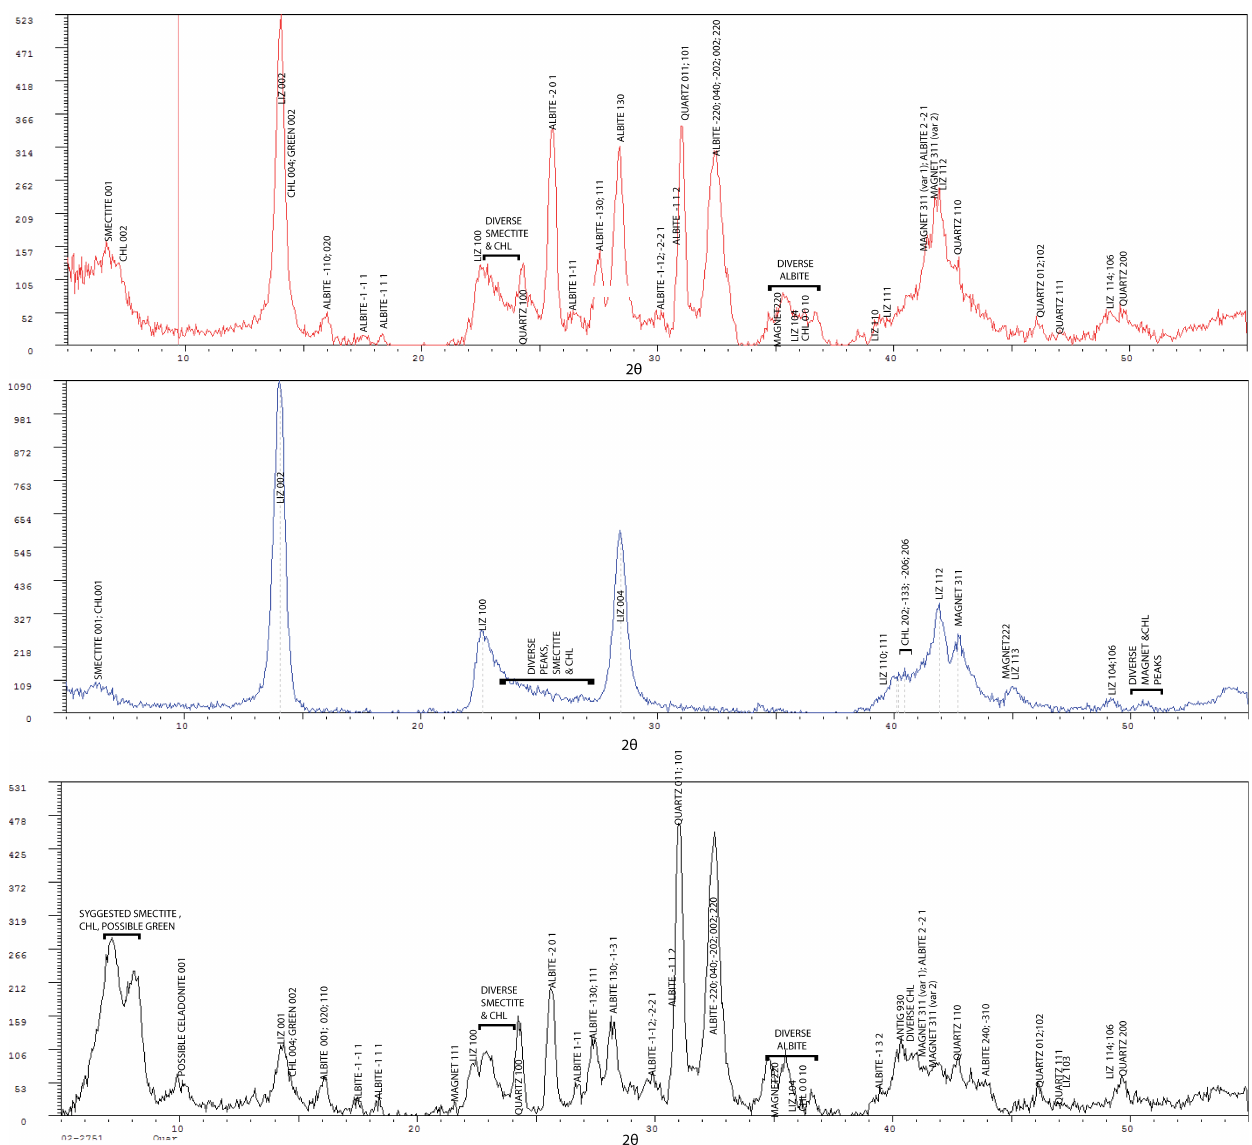
Figure 5. XRD profiles of representative samples from CROMO cores. Identified minerals are labeled, including smectite group clay min- erals, chlorite (CHL), lizardite (LIZ), antigorite (ANTIG), greenalite (GREEN), albite, quartz, magnetite (MAGNET), celadonite. Note that lizardite, antigorite, and greenalite are all types of serpentine and not easily distinguished from each other based solely on XRD. Top: a shal- low serpentine soil example; CROMO2, 3.5m below surface. Middle: a magnetite-bearing serpentinite; CROMO2, 25.9m below surface. Bottom: an example of a mixed core sample, with serpentine associated with products of basalt alteration in the subsurface; CROMO1, at 33.5m below